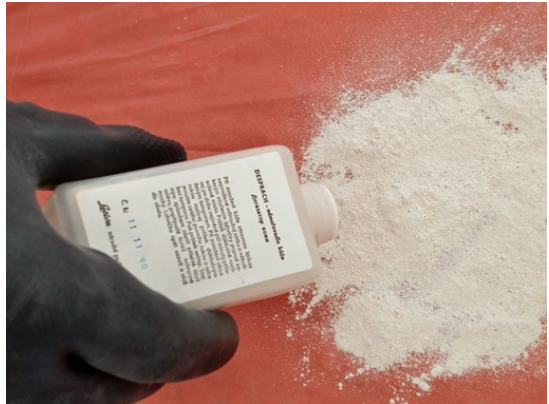
Figure 1. Application of Desprach sorbent to a contaminated surface.